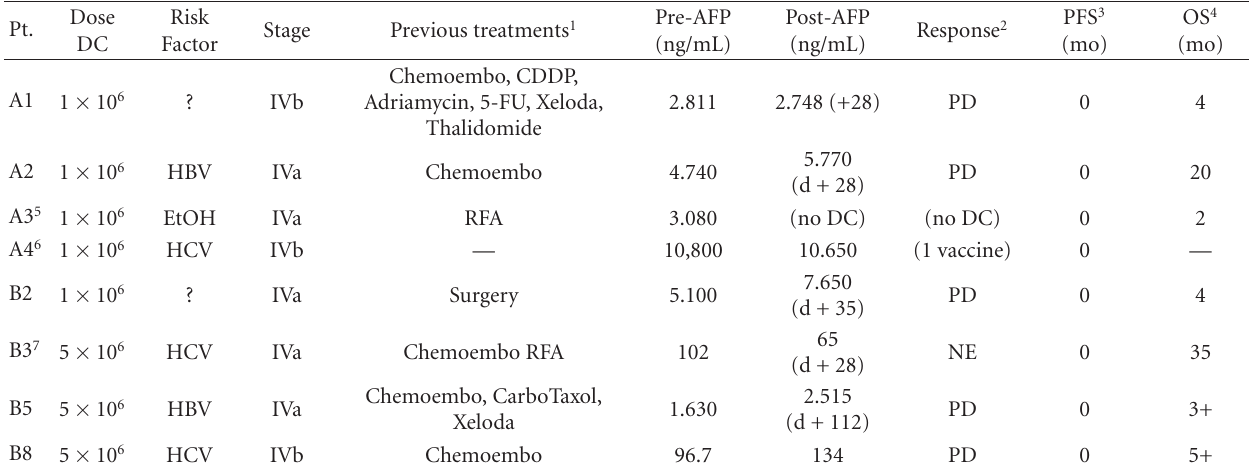
Table 1: HCC patient